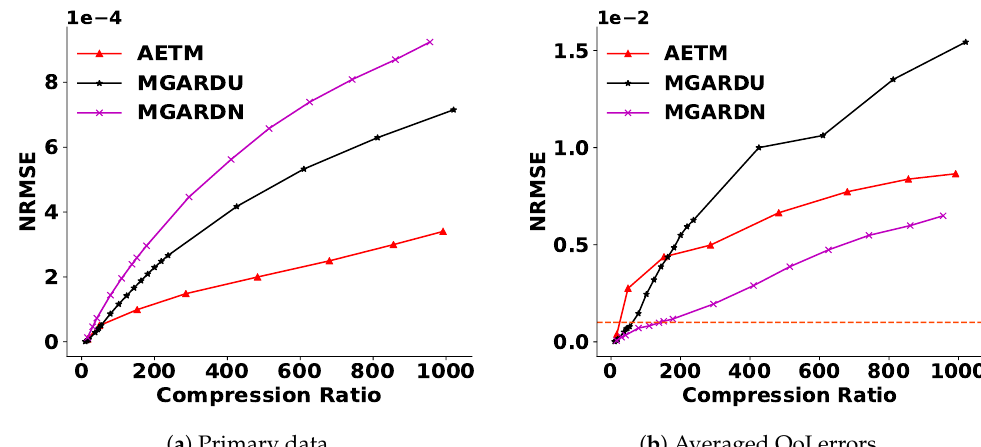
Figure 3. Reconstruction error comparison of PD ( a ) and the average of six QoI ( b ) between AETM, MGARDU, and MGARDN. The abbreviations here and in all other figures are expanded in Table 1. The horizontal line here and in Figures 4, 5b and 6 indicate the acceptable QoI error threshold. The graphs show that AETM outperforms the two versions of MGARD in terms of PD NRMSE, but QoI errors of AETM need to be